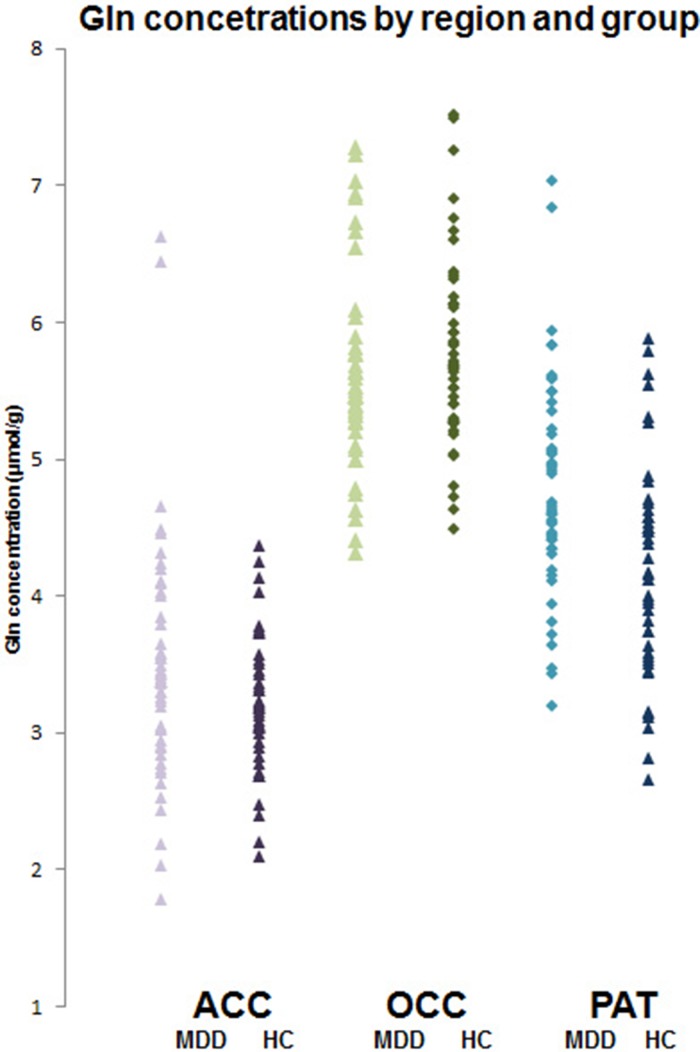
Individual glutamine concentrations (μmol/g) in depressed patients (MDD) and healthy controls (HC) in ACC, OCC and PUT. Mean glutamine level in patients in PUT is significantly higher (t = 3.30; p < 0.001, t test).